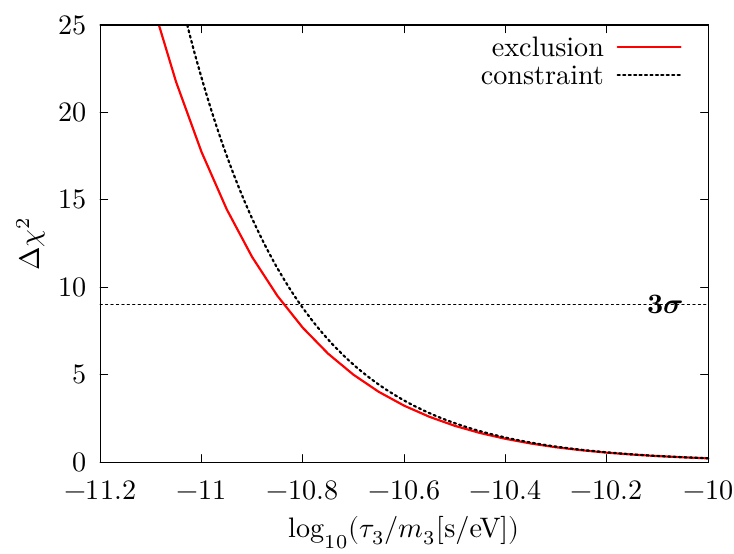
Figure 7 . The exclusion ability of the stable-neutrino case m 3 =(cid:28) 3 = 0 (the red curve) and the con- straint on (cid:28) 3 =m 3 assuming the stable-neutrino case (the black curve). The solid curve corresponds to MOMENT. The exclusion ability is de(cid:12)ned as (cid:1) (cid:31) 2 for the hypothesis m 3 =(cid:28) 3 = 0 for various true values (the x-axis value). We (cid:12)nd the exclusion ability could reach 3 (cid:27) while (cid:28) 3 =m 3 is below 10 (cid:0) 10 : 8 s/eV for MOMENT.